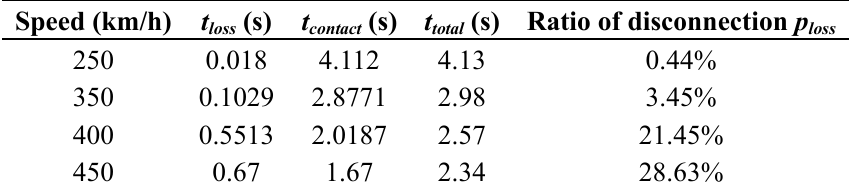
Table 1. Disconnection